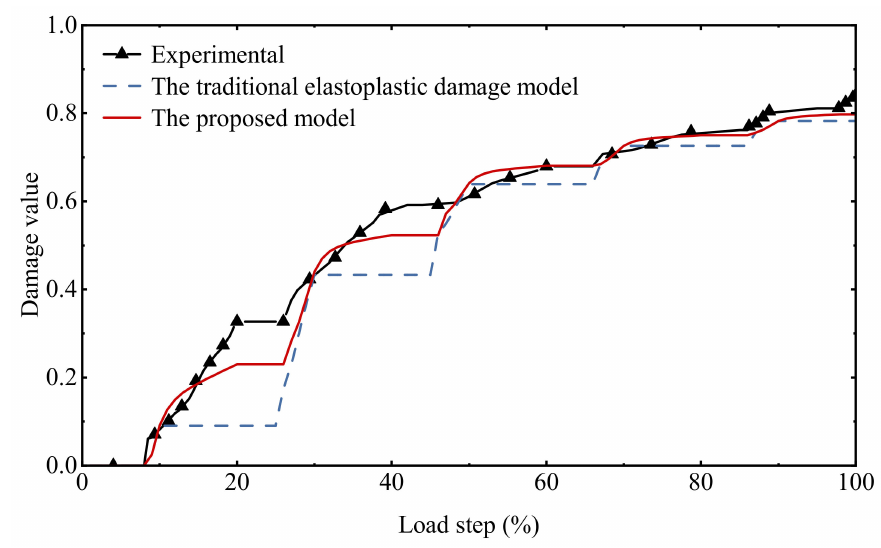
Figure 12. Comparison of damage history under uniaxial cyclic tensile